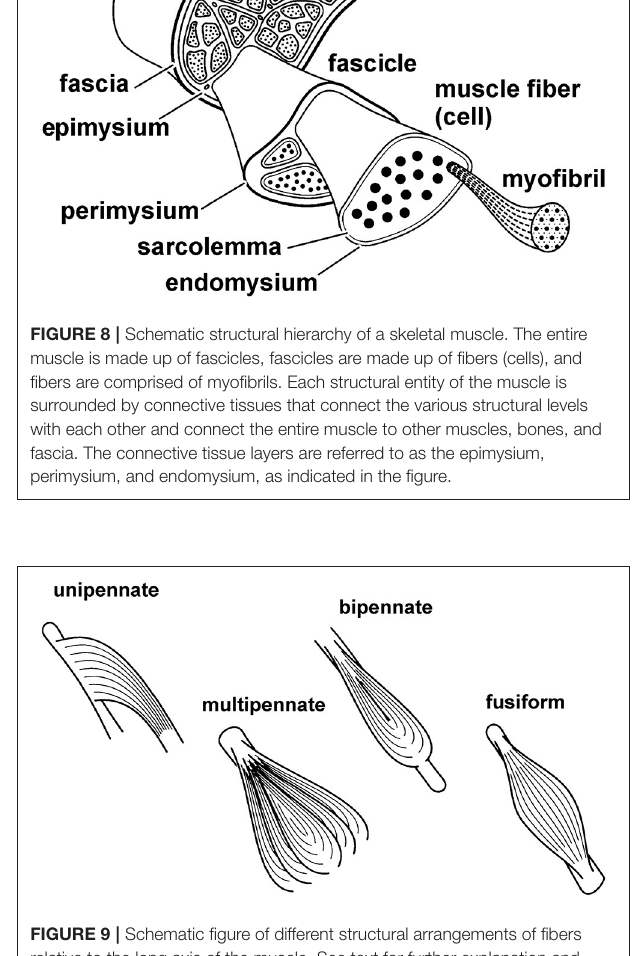
FIGURE 7 | Micrograph of a single myofibril (top panel) with the typical dark (A-band) and light (I-band) striation pattern and a corresponding sarcomere (middle panel) with a schematic representation of the sarcomere (bottom panel) including the appropriate labeling.